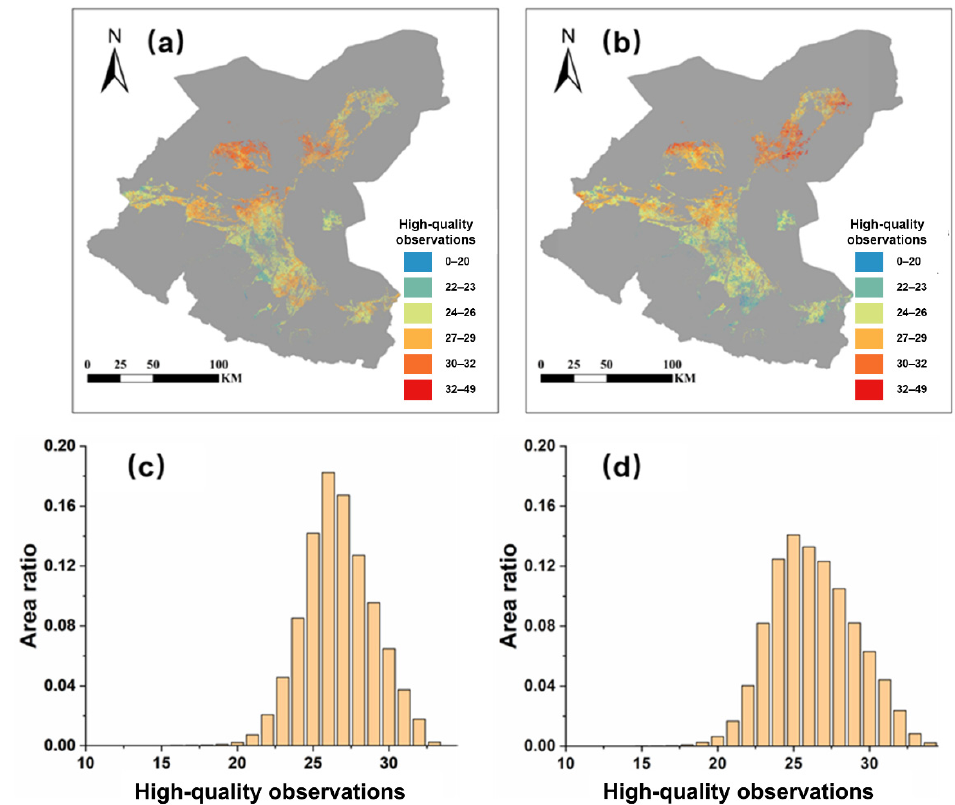
Figure 2. Spatial distribution of high-quality observations of Sentinel-2 image time series during the growing season for ( a ) 2019 and ( b ) 2020, and ( c , d ) the corresponding histograms.